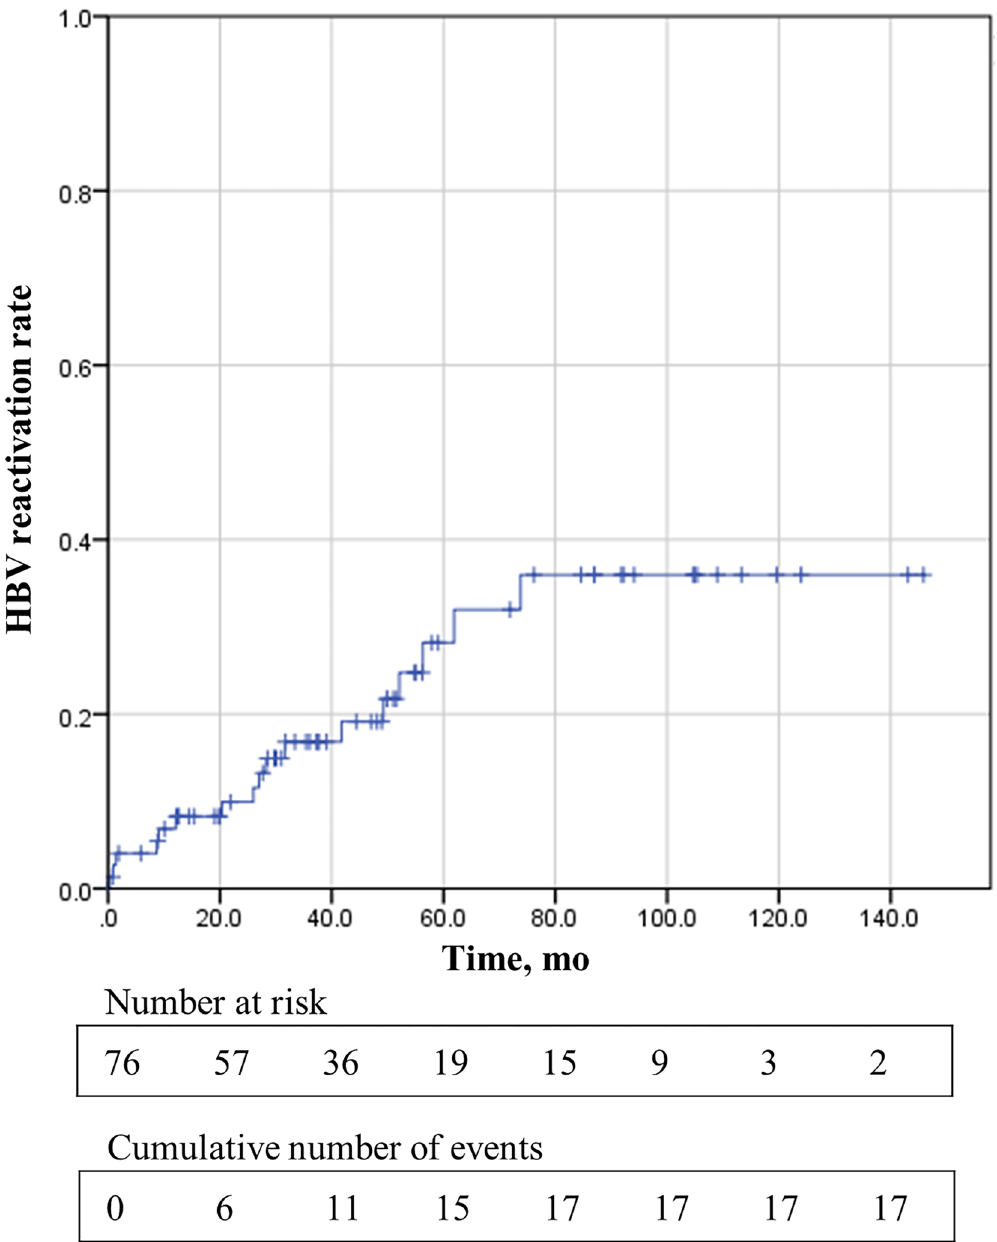
Figure 1. Kaplan–Meier curve for cumulative probability of HBV reactivation in 76 HBsAg positive